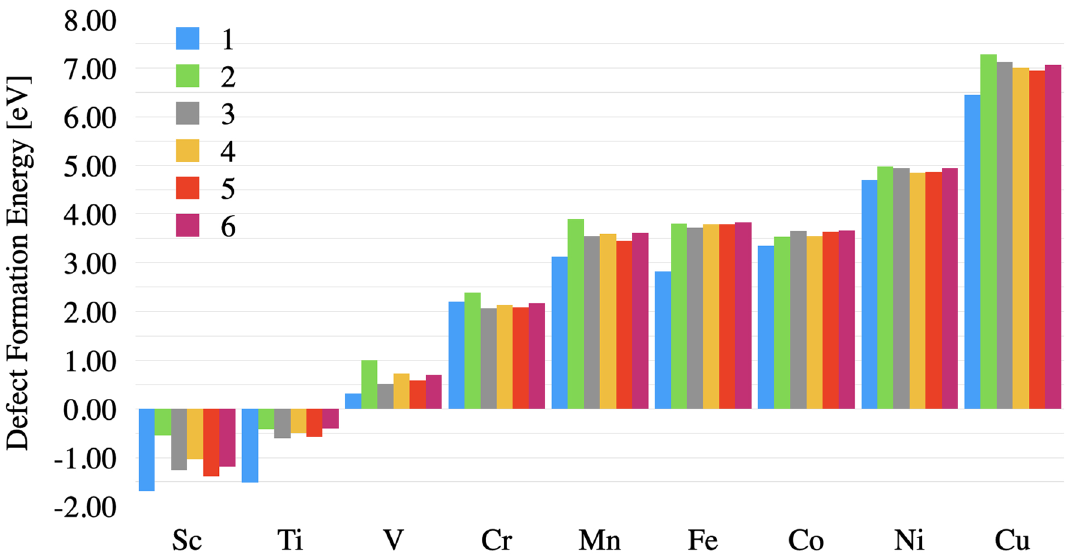
Figure 2. Defect formation energy of transition metal doped alumina as a function of dopant species and surface depth (1–5 as illustrated in Fig. 1). Position 6 shows the defect formation energy of bulk doped α -alumina reported in references 12,13